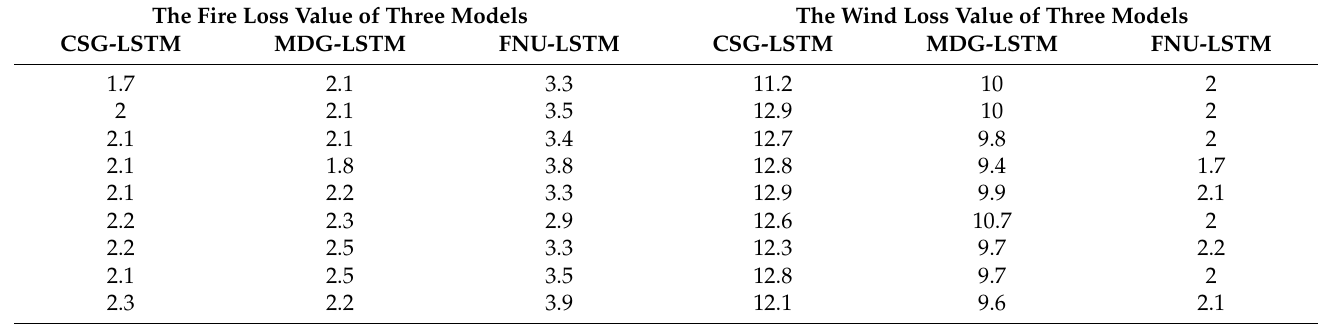
Table 6. The loss value of three